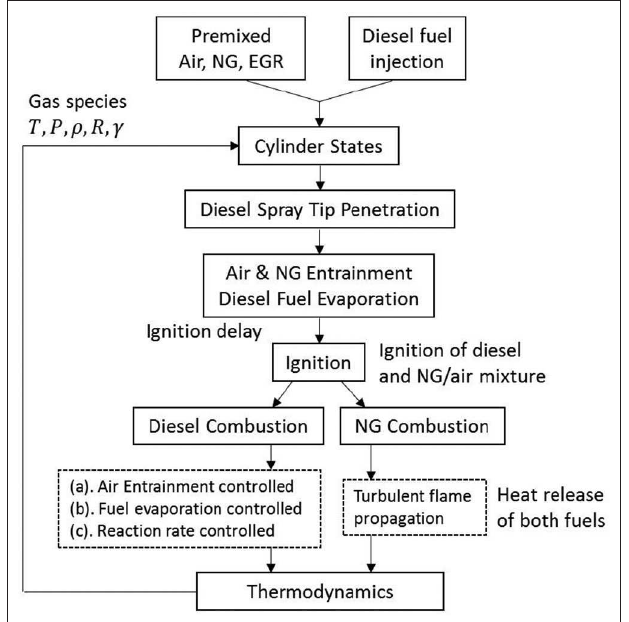
FIGURE 3 | A schematic description of computing process in the dual-fuel combustion model.